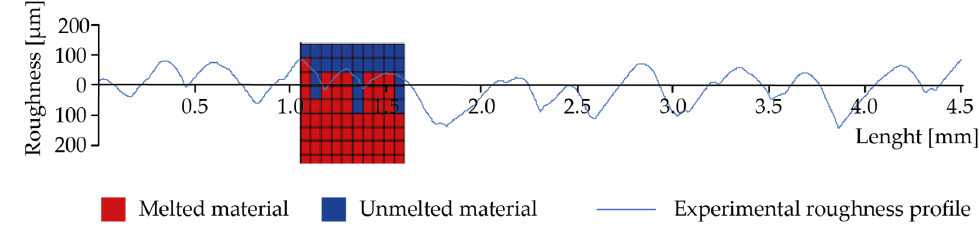
Figure 4. Comparison between the numerical and experimental roughness profiles.